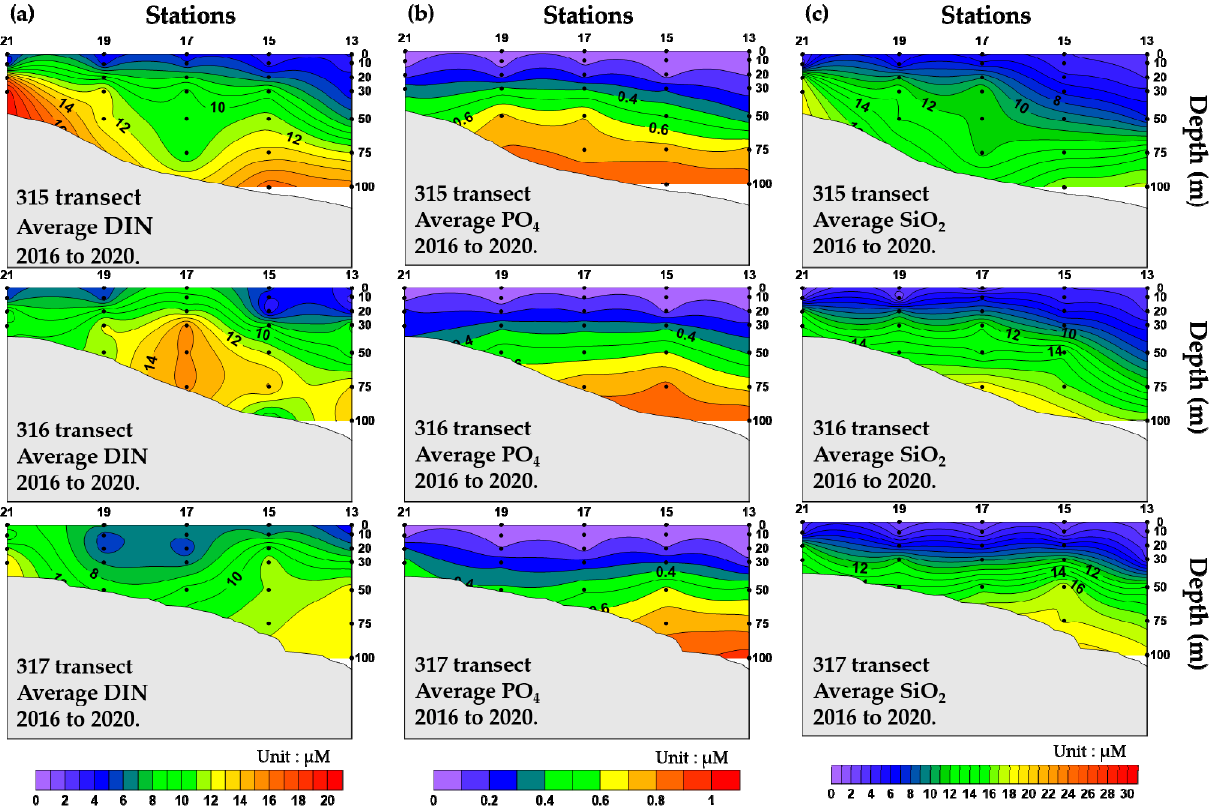
Figure 5. Spatial distributions of average surface dissolved inorganic nitrogen ( a , DIN), PO 4 ( b ), and